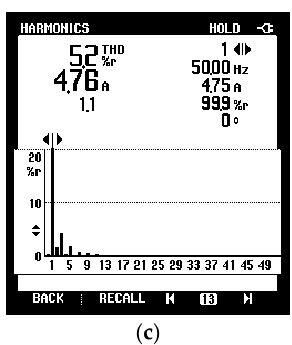
Figure 4. Experimental waveforms for qSBI when V dc = 120 V, D = 0.2, and M = 0.8. From top to bottom: ( a ) load current, inductor current, capacitor voltage, DC-link voltage; ( b ) capacitor current, capacitor